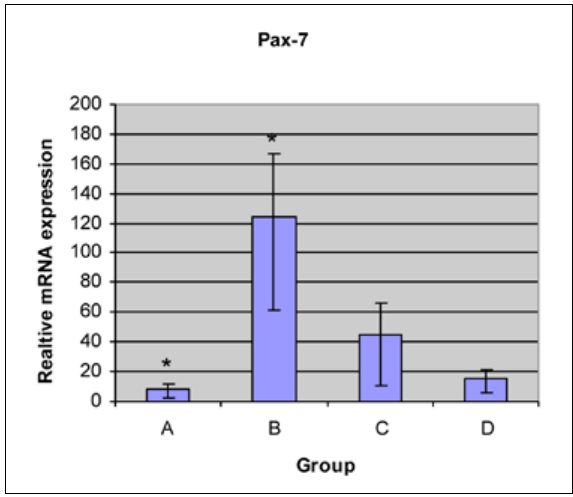
Figure 3. Expression of Msx-1 by human embryonic stem cells – Day 8 ( * p < 0.05). Early addition of noggin and the late addition of BMP4 (Group C) significantly different to late addition of BMP4, alone (Group B). * p < 0.05, reflecting a significant difference between the means of the groups.